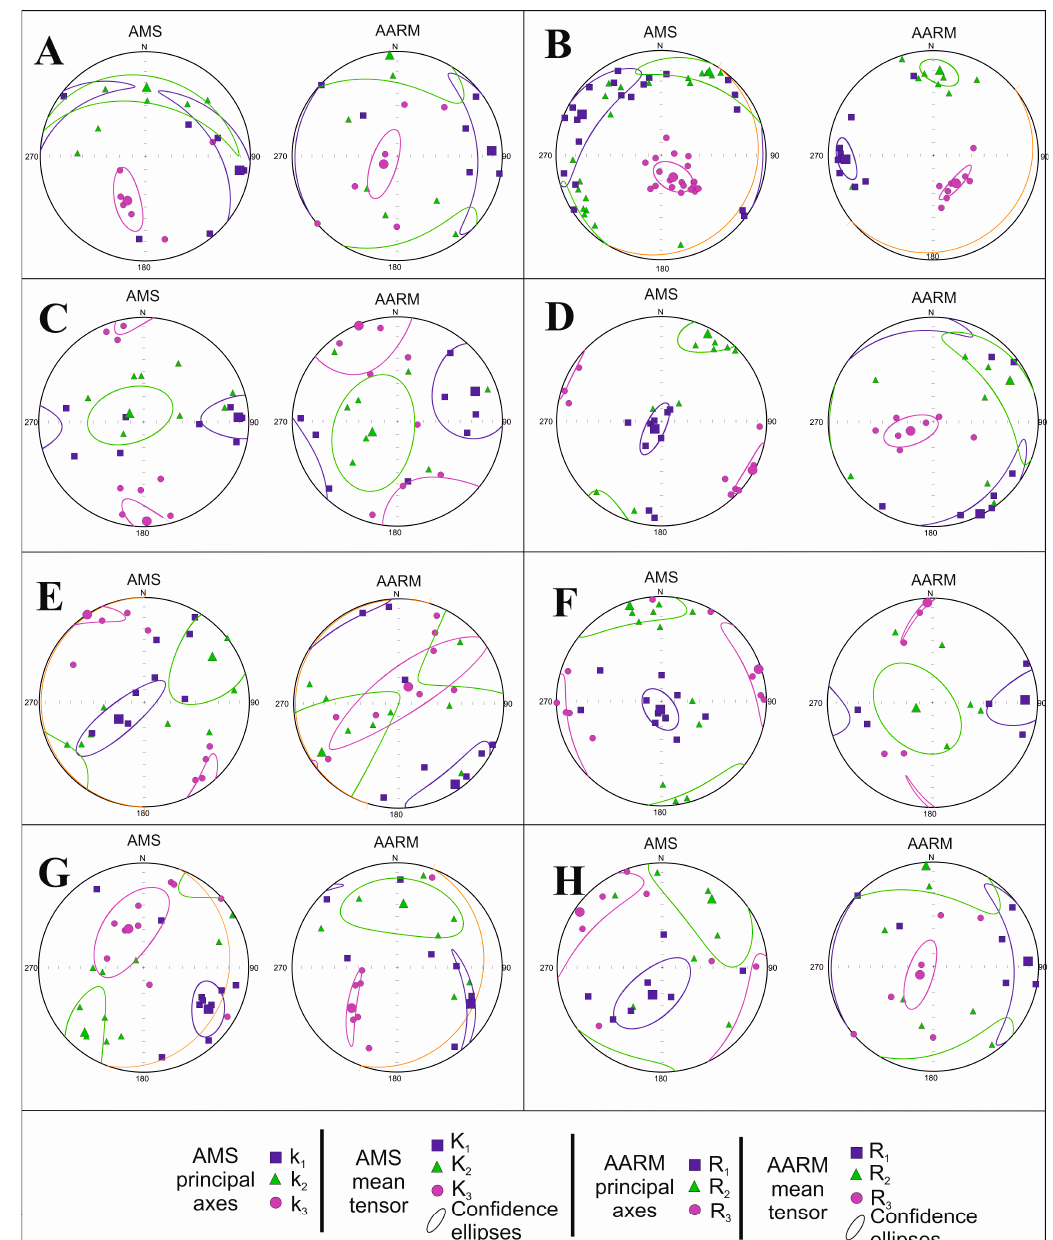
Figure 7. Comparison of AMS and AARM data for the selected sites. ( A ) Site 24_17, Kharaelakh intrusion, N-type of AMS. ( B ) Site sm12_21, lava flow of the Samoedsky Formation, N-type of AMS. ( C ) Site 48_17, Talnakh intrusion, I-type of AMS. ( D ) Site 5_16, Yergalakhsky sill, R-type of AMS and N-type of AARM. ( E ) Site 1_21, lava flow of the Samoedsky Formation, R-type of AMS and N-type of AARM. ( F ) Site 11.2_16, dike of the Daldykan complex, I-type of AMS and N-type of AARM. ( G ) Site kul32, Katangsky sill, N-type of AMS. ( H ) Site 26_17, Kharaelakh intrusion, R-type of AMS.